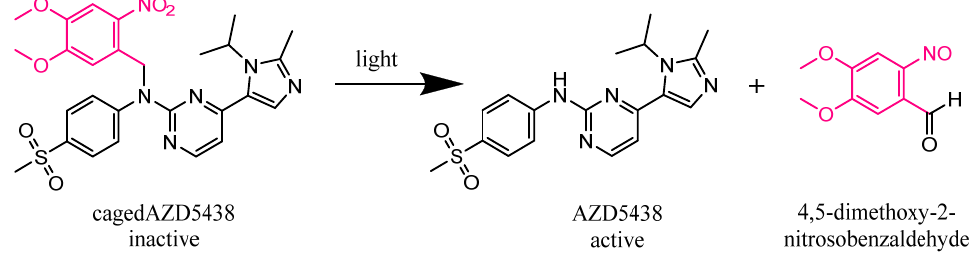
Figure 1. Expected photolysis reaction of the inactive kinase inhibitor AZD5438 caged with the photoremovable protecting group 4,5-dimethoxy-2-nitrobenzyl (DMNB) (cagedAZD5438) to the active AZD5438 and the separated protection group according to Klán et al. [3].